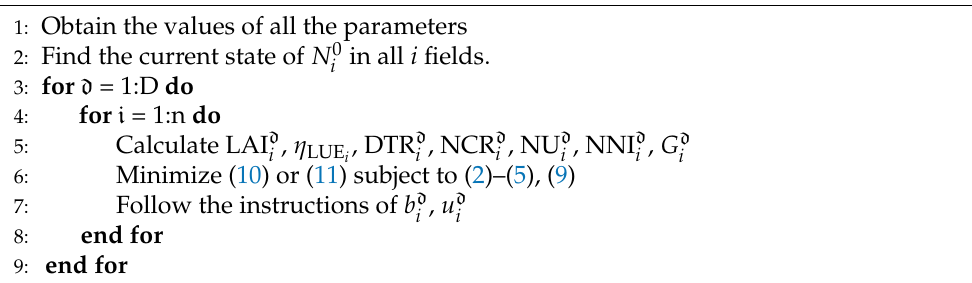
Algorithm 1 N-fertilizer application decision support system